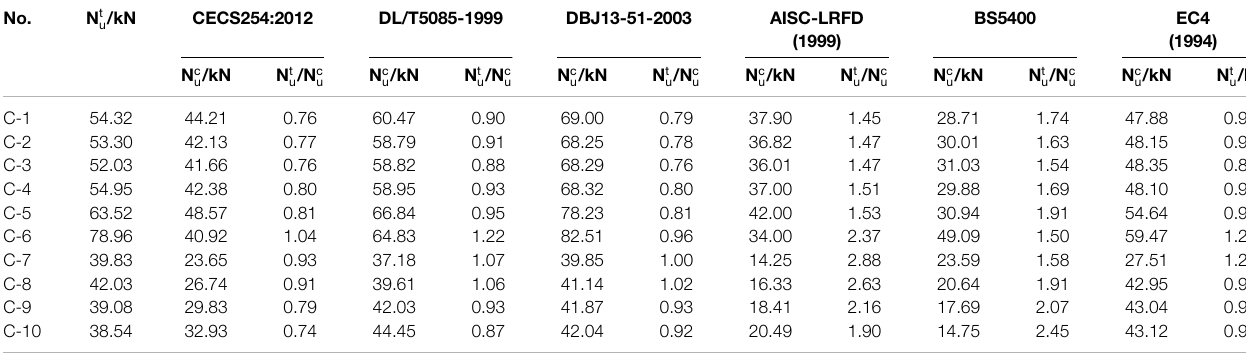
TABLE 9 | Contrast results between N t u and N c u .